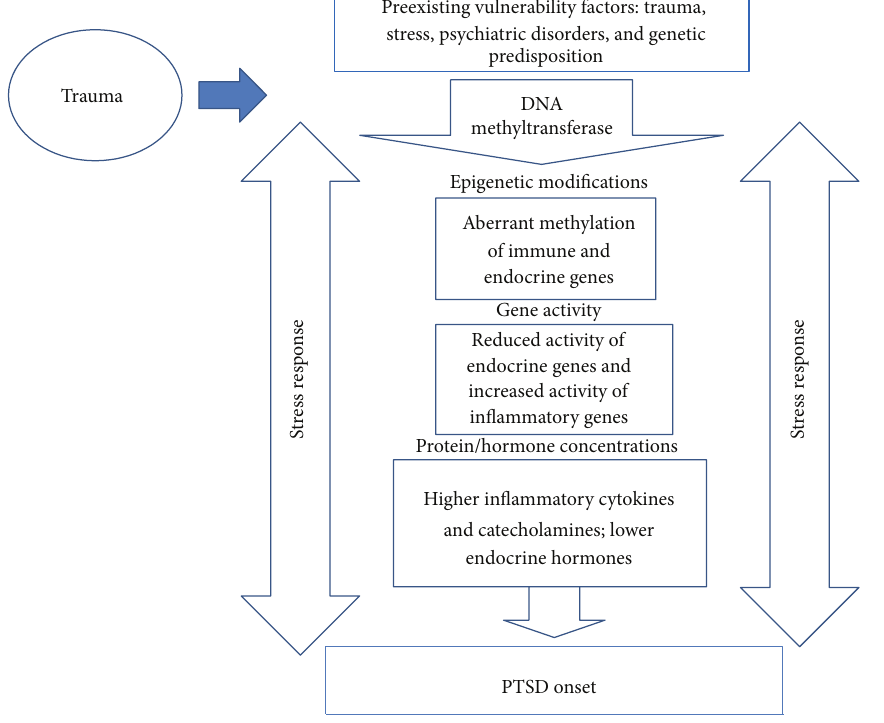
Figure 1: Epigenetic mechanisms of PTSD